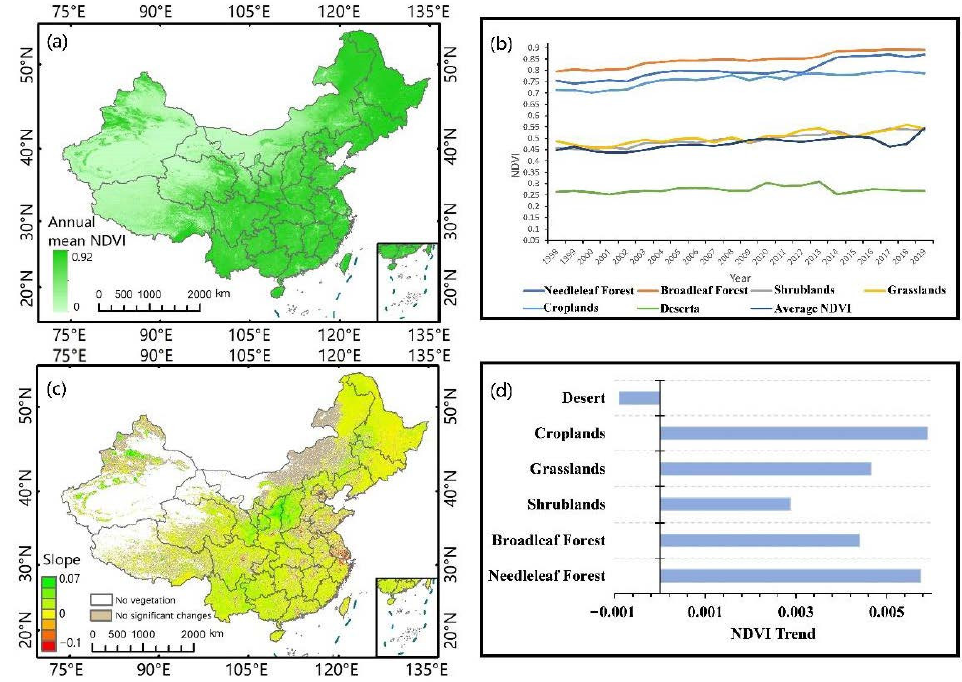
Figure 3. ( a ) Average NDVI; ( b ) annual NDVI values of different vegetation; ( c ) NDVI trend; and ( d ) NDVI trends of different vegetation in China from 1998 to 2019.